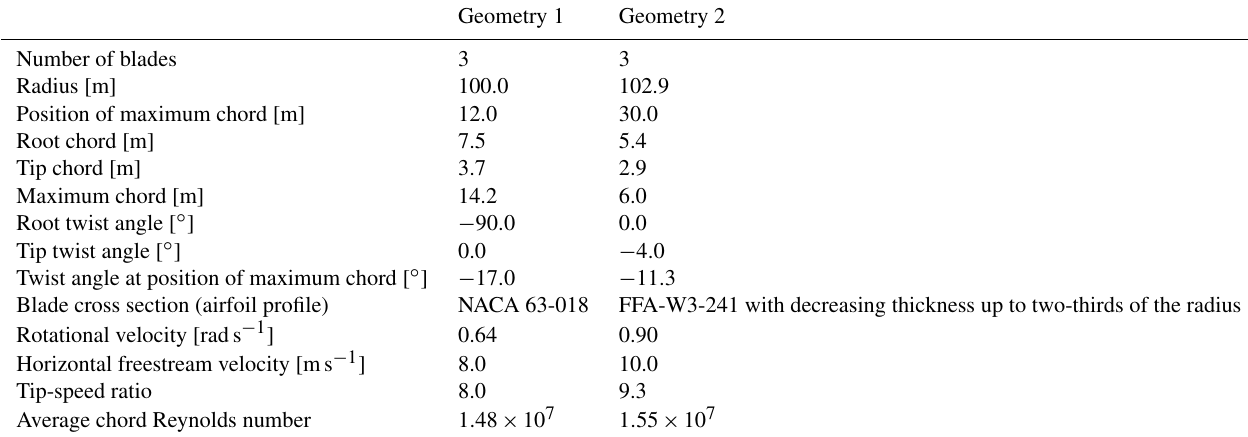
Table 2. Physical parameters of the wind turbines.